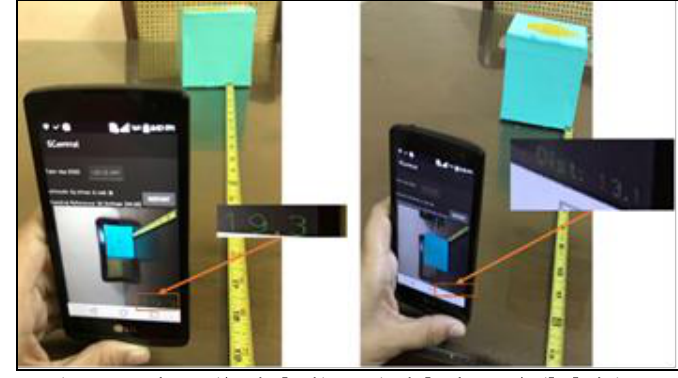
Figura 7: Obtención de la distancia del robot móvil al objeto. Fuente: Los autores, (2018).